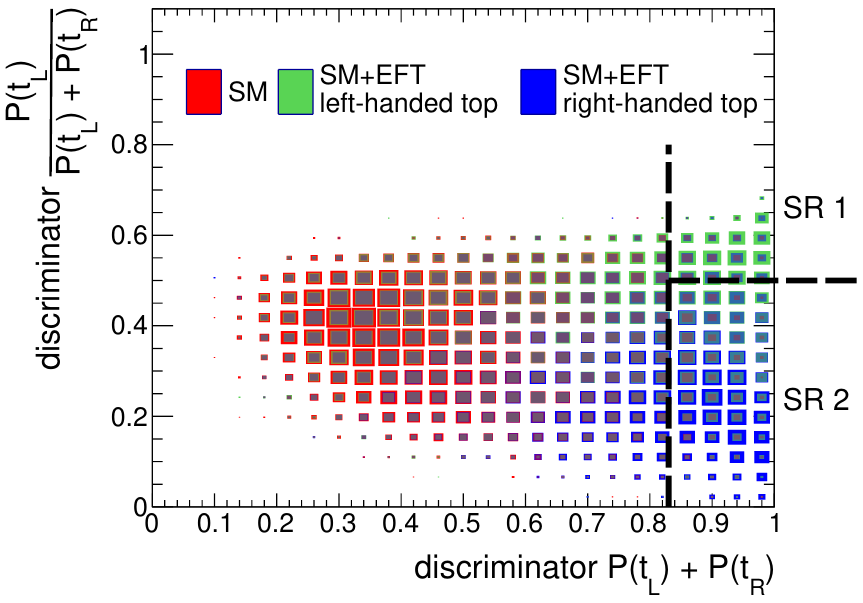
Figure 13 . Normalized distributions of the combined NN outputs for events corresponding to SM (red), SM+EFT ( t L operators) (green) and SM+EFT ( t R operators) (blue). The Wilson coe(cid:14)cients are set to 20 (TeV (cid:0) 2 ). The size of each box is proportional to the abundance of events of the corresponding sample. The discriminators on the x and y axis are as de(cid:12)ned in table 2. The dashed lines de(cid:12)ne SR1 and SR2. See text for more